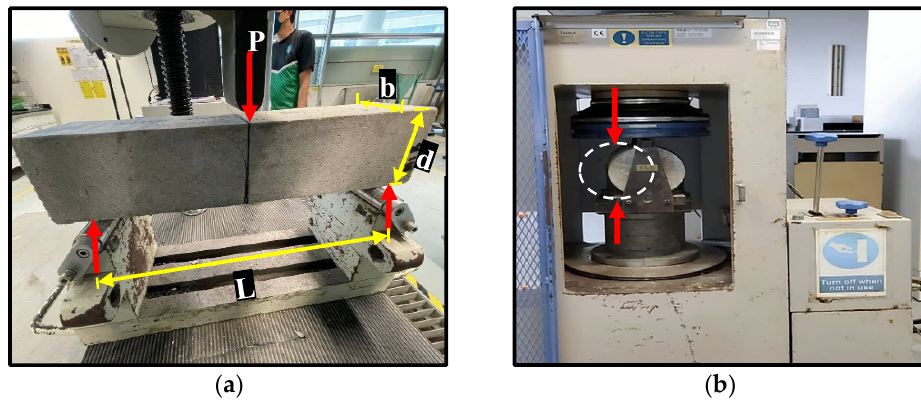
Figure 4. ( a ) Three-point loading flexural test. ( b ) Splitting tensile strength test.